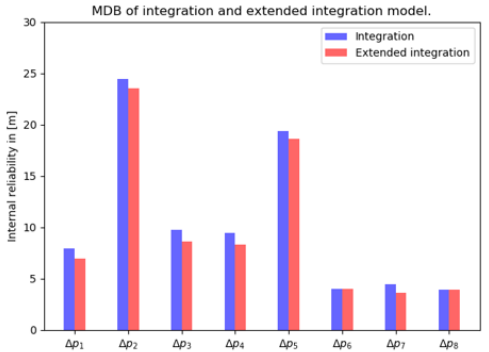
Figure 12. Internal reliability: MDB for a single outlier in GNSS pseudorange measurements, in integration (blue) and extended integration model (red), with 8 satellites and 4